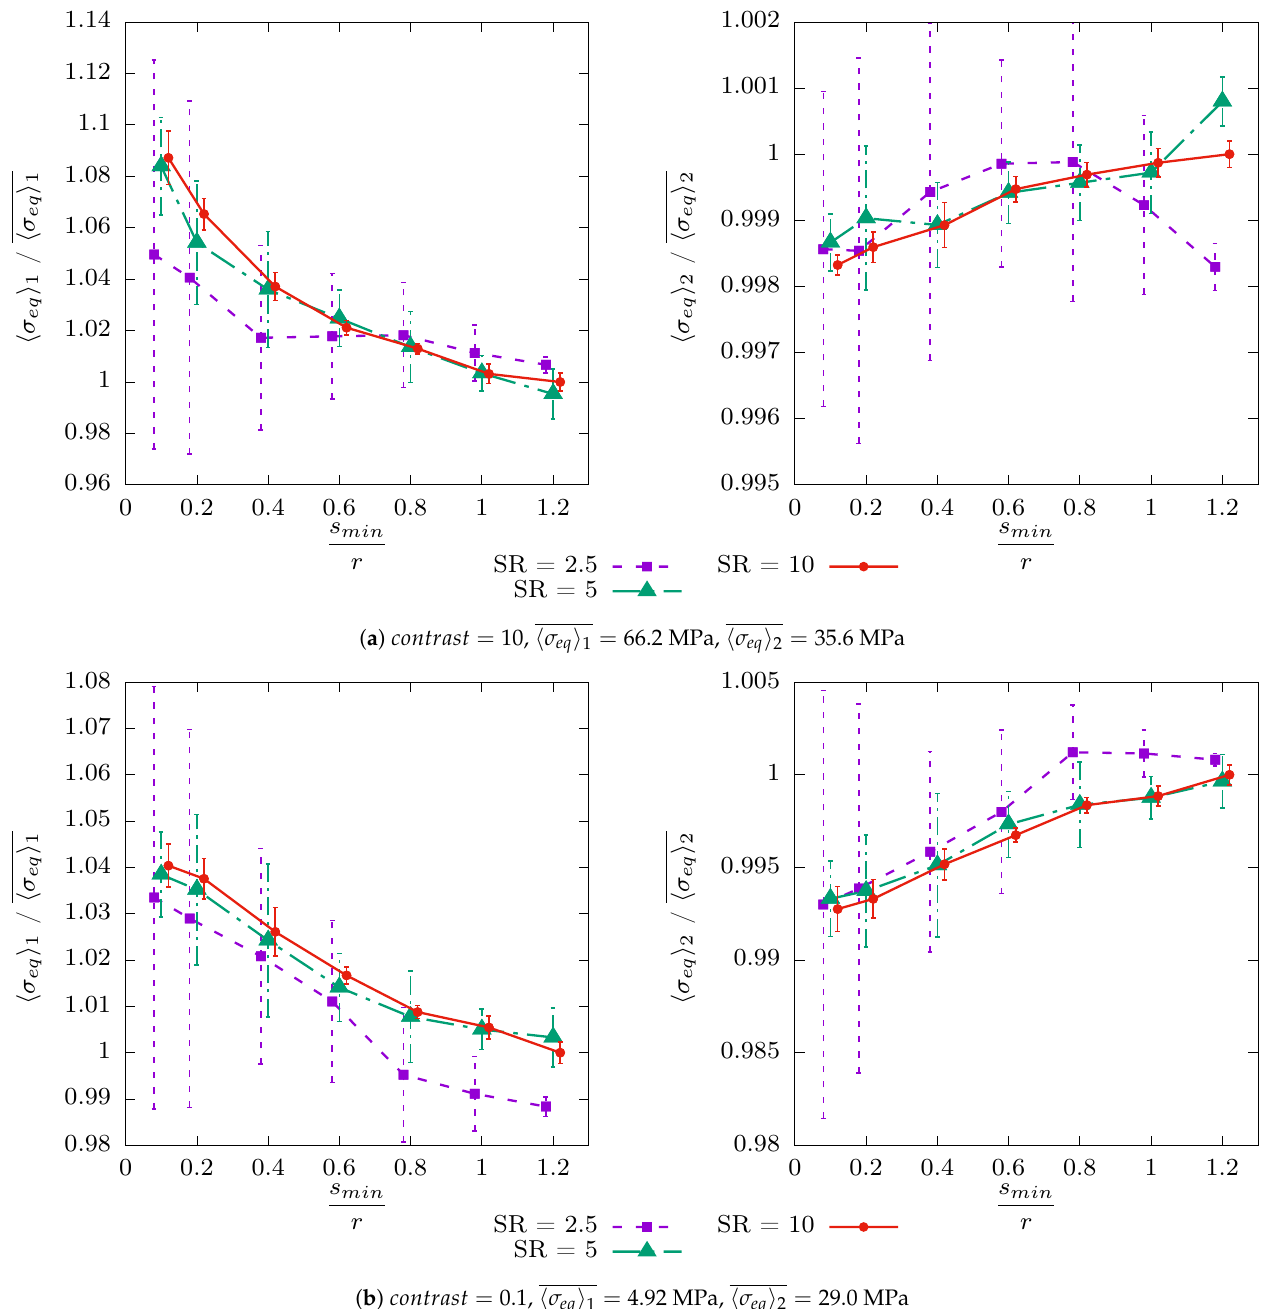
Figure A5. Mean values and standard deviations on the mean value for the first moment of equivalent stress by phase as a function of the packing parameter s min / r ( r = 10 µ m) for a volume fraction of inclusions f v = 13.4 %. For clarity, the error bars and dots are slightly shifted around for each studied minimum